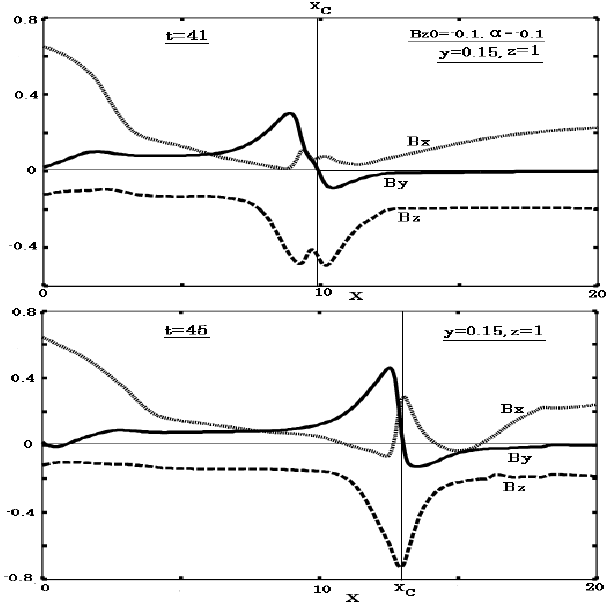
Fig. 10. x-directional profiles of magnetic field components B x ,B y and B z at y = 0 . 15 and z = 1 . 0 at times t = 41 and 45 for the case Figure 10: x-directional proflles of magnetic fleld compo- of B z 0 = − 0 . 1 and α = − 0 . 1, where the plasmoid center X C is in- nents B x ; B y and B z at y = 0 : 15 and z = 1 : 0 at times t = 41 Figure 10: x-directional proflles of magnetic fleld compo- and 45 for the case of B z 0 = nents B x ; B y and B z at y = 0 : 15 and z = 1 : 0 at times t = 41 plasmoid center X C is indicated. and 45 for the case of B z 0 = plasmoid center X C is indicated.